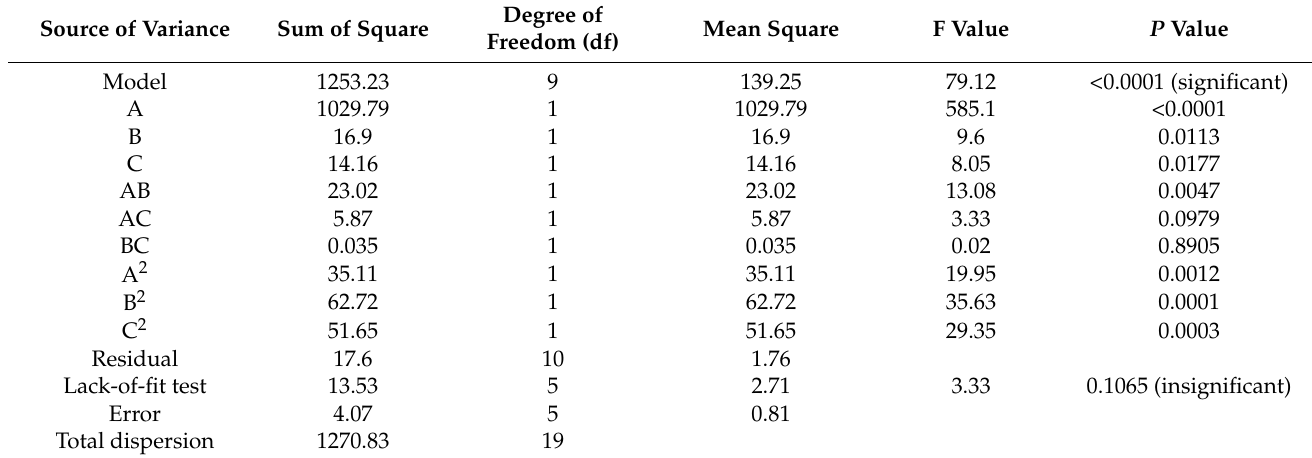
Table 3. Variance analysis of the quadratic equation model.